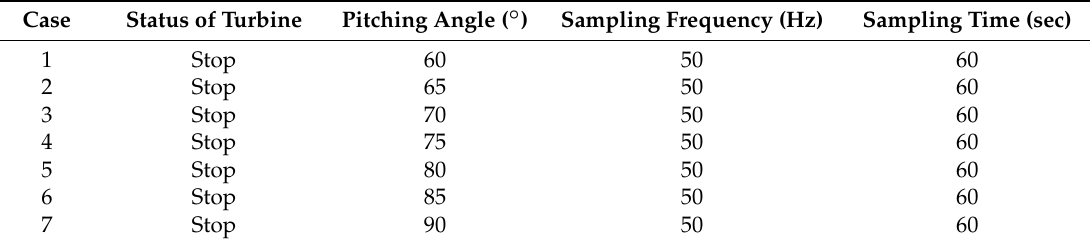
Table 7. The testing cases to compare with the 2D wind